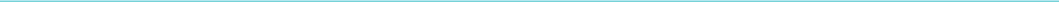
Figure 5: Illustrates the single amino acid code for a portion of the amino acid residues of the B pocket of the HLA molecules and the principal patterns of peptide binding by the HLA-B and HLA-C allomorphic molecules associated with significantly increased and decreased psoriatic arthritis susceptibility. The preferential peptide binding specificity of the allomorphs for binding particular amino acid side chains at the second position of the peptide P2 is shown. At positions 45, 67 and 74 in the HLA-B alpha chain that forming critical parts of the B pocket, HLA- B*27:05:02, HLA-B*39:01:01 and B*38:01:01 have the same negatively charged amino acid residues, and these allomorphs have been de- fined to preferentially bind peptides containing positively charged arginine or histidine at P2. Conversely, the B*44 allomorphs associated with significantly decreased susceptibility to psoriatic arthritis are characterized with positively charged lysine at position 45, conferring the prefer- ence to bind peptides with negatively charged amino acids at P2. The somewhat related properties of B*08:01:01 and C*06:02:01 are